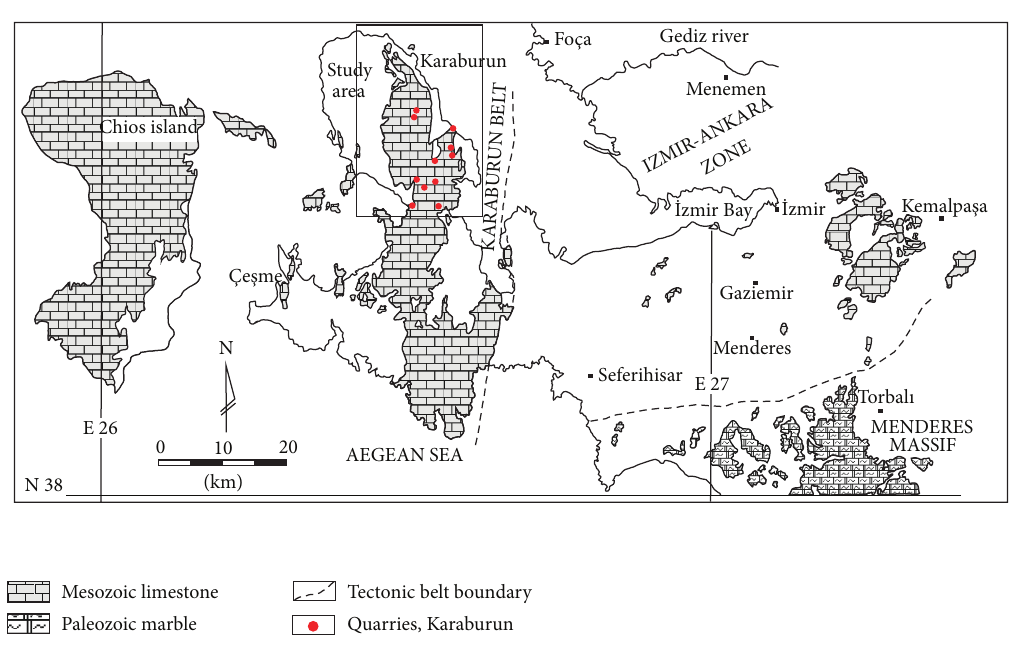
Figure 3: Location map of the study area and the outcrop of Mesozoic carbonate rocks in ˙Izmir Province modified from Yakut [26] and G¨ung¨or and Erdo˘gan